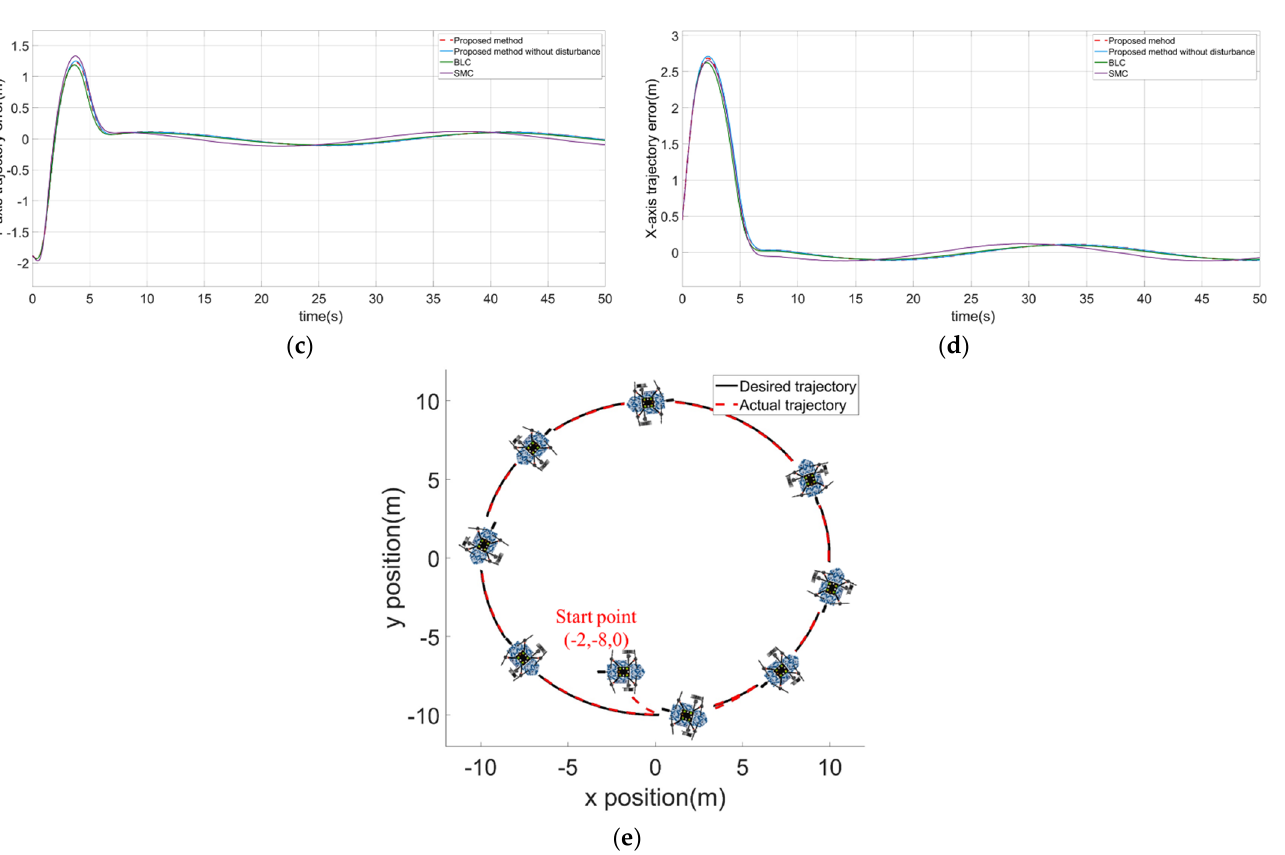
Figure 19. The robot tracks the desired trajectory on the water surface. ( a ) The position control results of the X-axis. ( b ) The position control result of the Y-axis. ( c ) The trajectory tracking error of the X-axis. ( d ) The trajectory tracking error of the Y-axis. ( e ) The robot tracks the desired trajectory by the proposed control method.